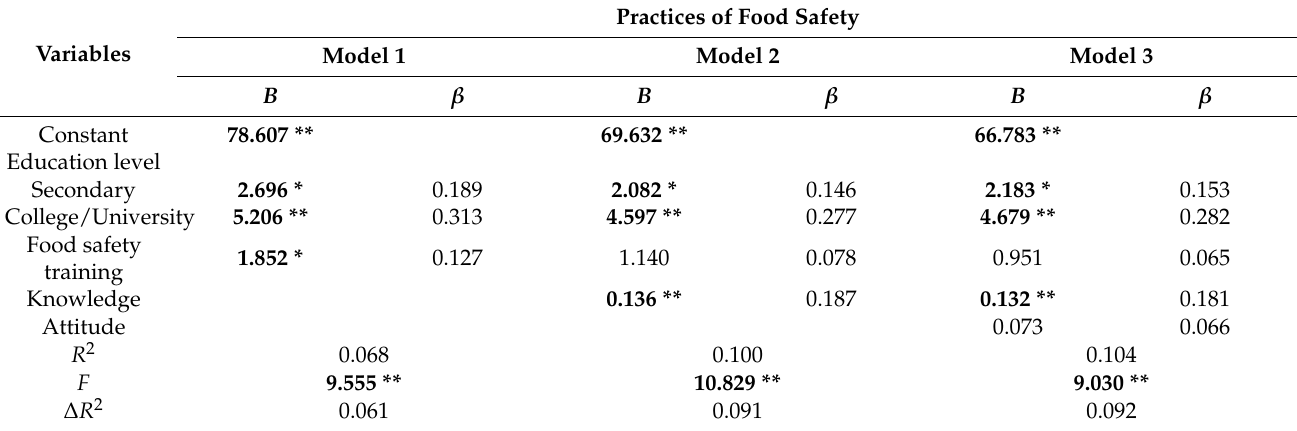
Table 3. Hierarchical multiple regression predicting the practices of food safety during the COVID-19 pandemic (N =